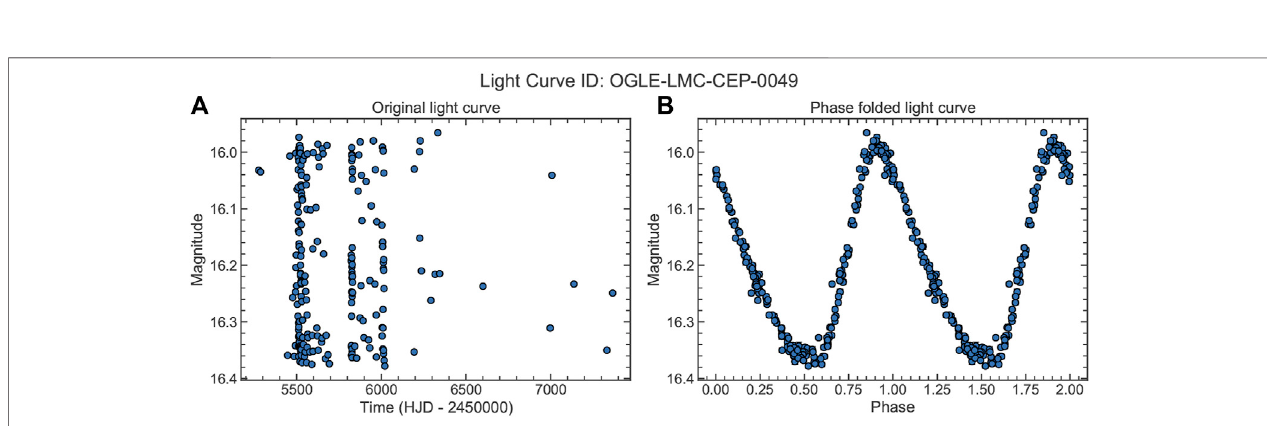
FIGURE 1 | Representative bi-dimensional histograms generated from the OGLE light curves for fi ve variability classes (from left to right) : Cepheids, δ -Scuti variables, Eclipsing Binaries, Long-period Variables, and RR Lyrae. The x- and y-axis in each of the fi ve panels are the number of pixels (53 along x-axis and 90 along y-axis). The blue and yellow color represent the pixels with the least and the most number of points respectively.